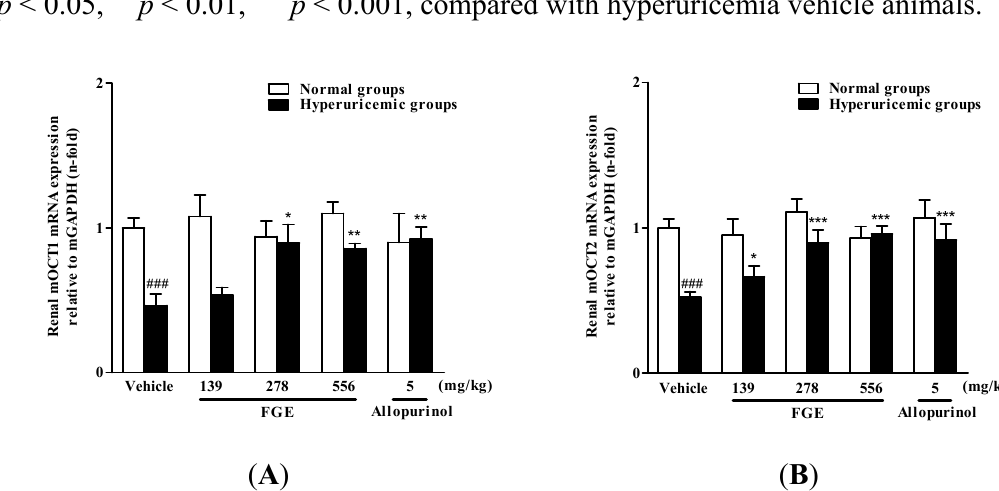
Figure 3. Effects of FGE and allopurinol on mRNA and protein levels of renal organic cation/cartinine transporters in hyperuricemic and normal mice. Kidney cortex mRNA was extracted for RT-PCR analysis of mOCT1 ( A ), mOCT2 ( B ), mOCTN1 ( C ) and mOCTN2 ( D ). Kidney cortex tissues were used for western blot analysis of mOCTN1, mOCTN2, mOCT1 and mOCT2 ( E ). The ratio of mOCT1 ( F ), mOCT2 ( G ), mOCTN1 ( H ) and mOCTN2 ( I ) density to α -tubulin density.